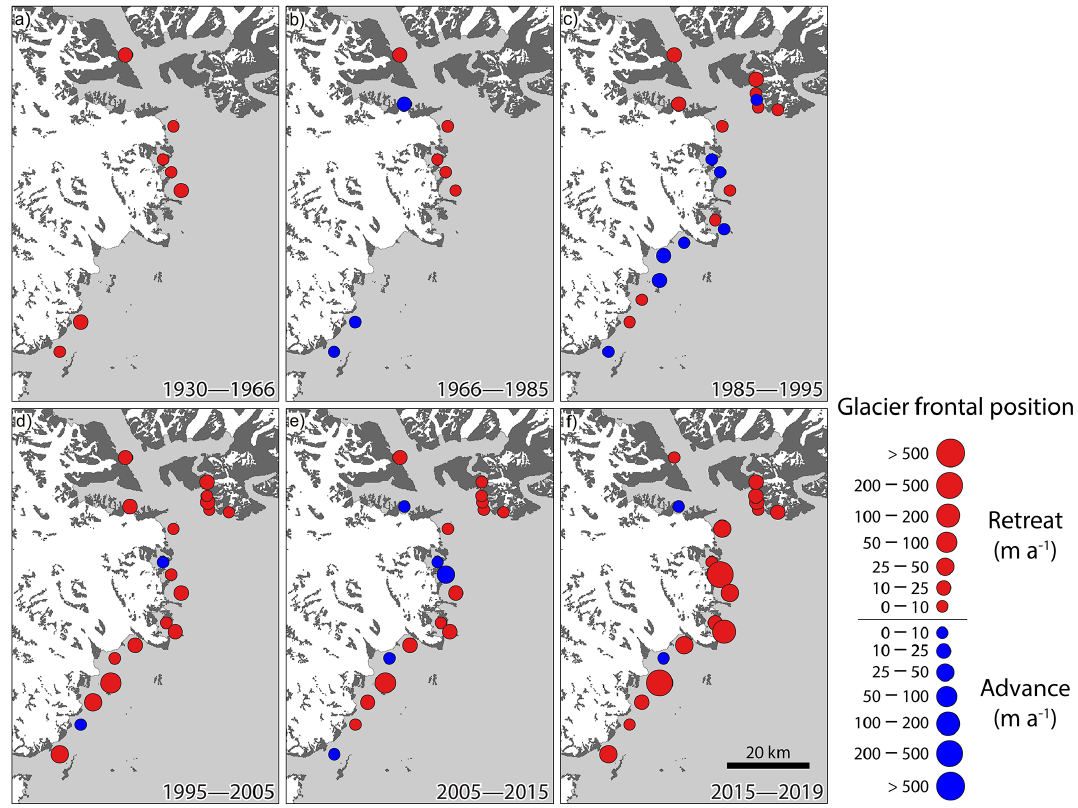
Figure 4. Graphical representation of annual rate of change in frontal position of glaciers in the northern region. Parts A to F show annual rates of change over the different time-steps that we have been able to generate from our various image sources. (a) BAARE mission (1930) to CORONA mission (1966). (b) CORONA mission (1966) to Landsat 5 (1985). (c) Landsat 5 (1985) to Landsat 5 (1995). (d) Landsat 5 (1995) to Landsat 7 (2005). (e) Landsat 7 (2005) to Landsat 8 (2015). (f) Landsat 8 (2015) to Landsat 8 (2019). Red circles represent retreat and green circles represent advance. Circles are sized proportionally to the magnitude of change. Most striking is the increased rate of glacier retreat in the most recent period